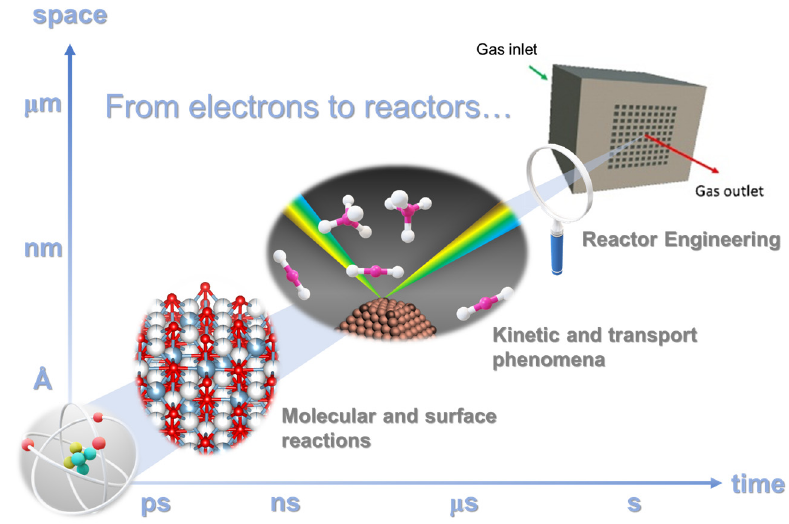
Figure 3. Time-space multiscale approach: from fundamental level to reactor engineering.